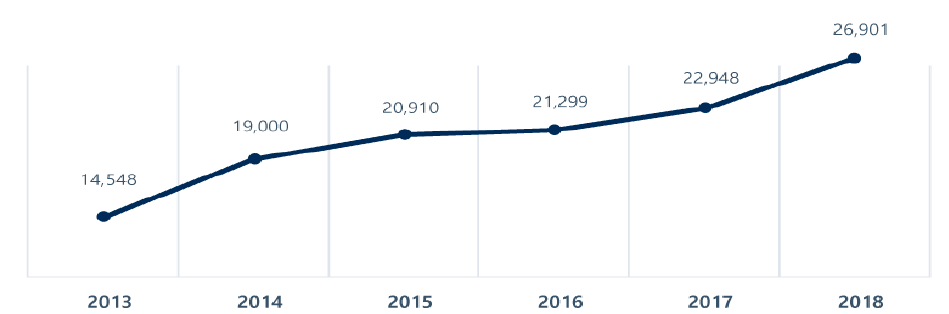
Figure 1. Foreign-invested companies in Korea.